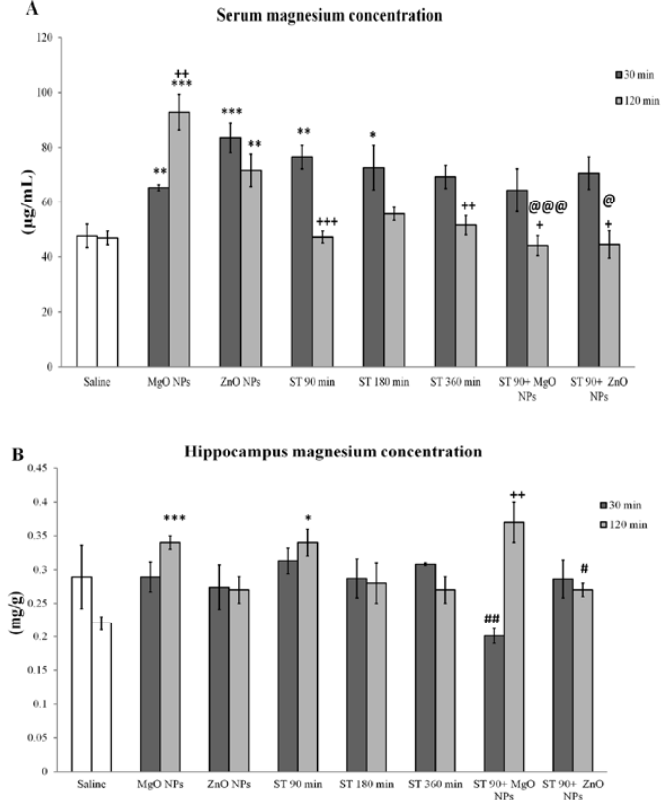
Fig. 2. Assessment of Mg 2+ concentration. *P<0.05, **P<0.01 and ***P<0.001 are in comparison with the control group at the same time (30 and 120 min). +P<0.05, ++P<0.01 and ++P<0.001 are between equal treatment groups in two different times. #P<0.05 and ##P<0.01 are in comparison with ST 90 min groups at the same time (30 and 120 min). @P<0.05 and @@@P<0.001 are in comparison with MgO NPs or ZnO NPs groups at the same time (30 and 120 min). All bars are means ± standard error of the means.